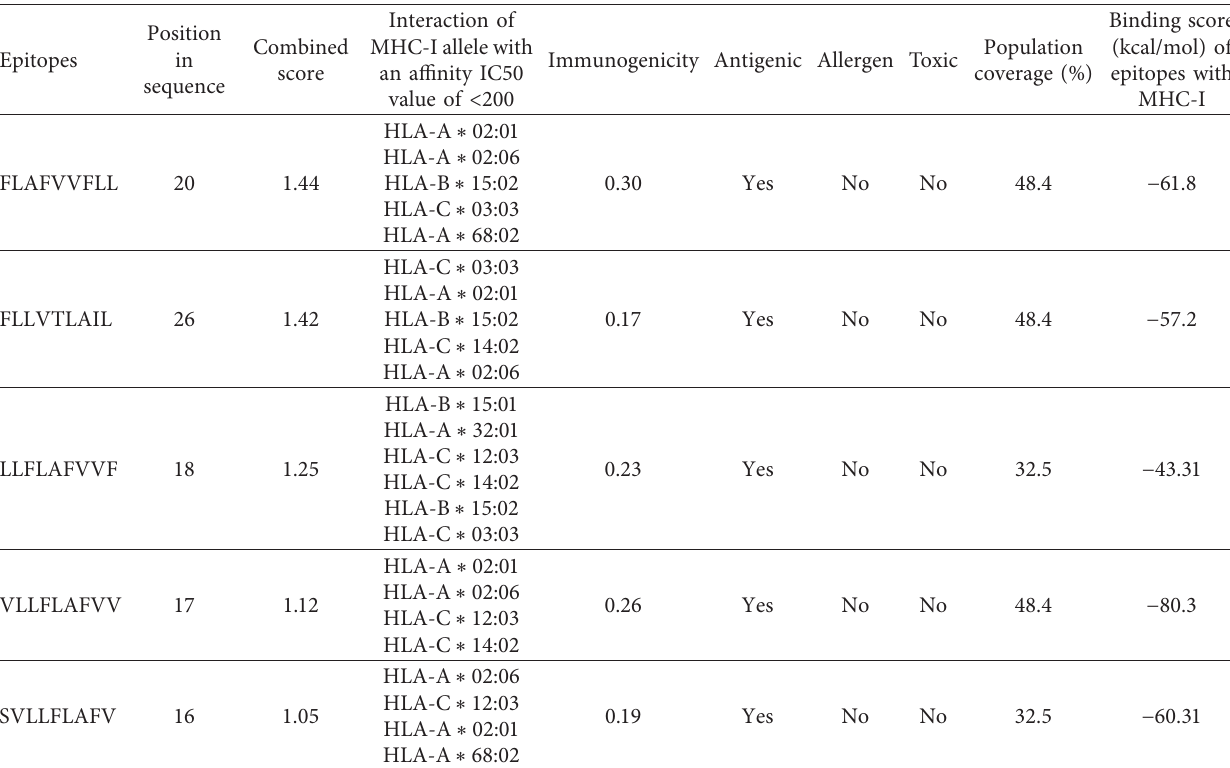
Table 2: List of CTL epitopes that have good combined score and are antigenic, nonallergic, and immunogenic, and bind with an affinity IC50 value of less than 200 with the MHC-I